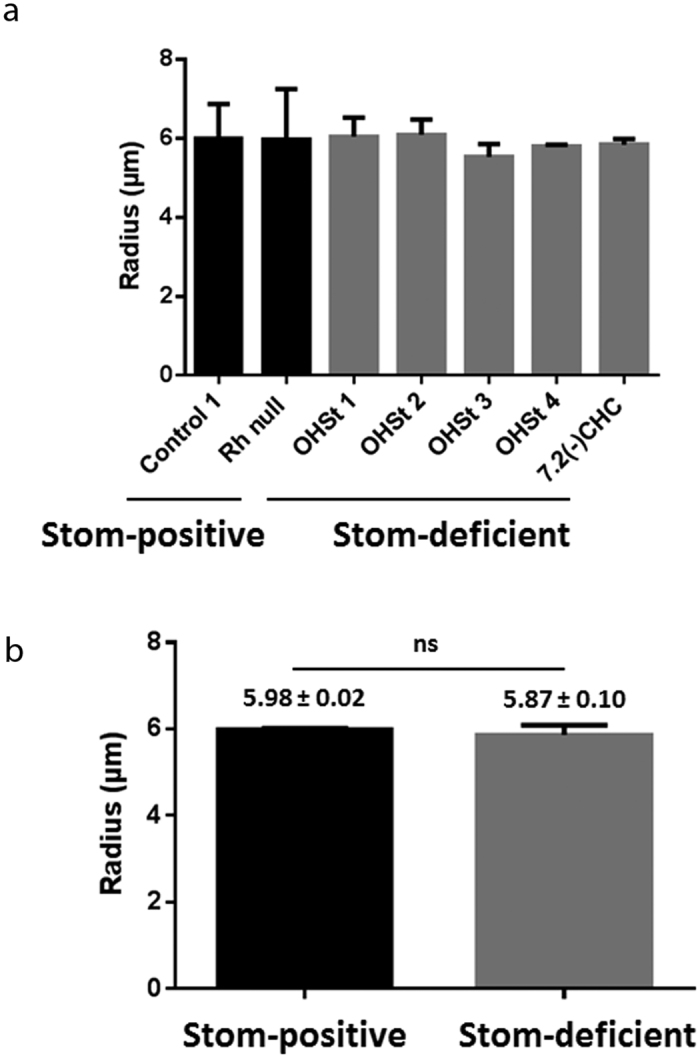
Analysis of the size of ghosts.(a) Means of ghost radius from two stomatin-positives (black bars), including one control and one Rhnull and five stomatin-deficients (grey bars), including four OHSt and one 7.2(−) CHC (+/− SEM). Measurements of 300 ghosts per individual from Zeiss Axio Observer Z1 microscope observations (X1000). (b) The comparison of stomatin-positive (black bars) and stomatin-deficient (grey bars) and determination of the means of the radius (μm) ± SEM revealed no significant (ns) differences corresponding to p > 0.05 (0.5082), as determined with an unpaired Student t test.